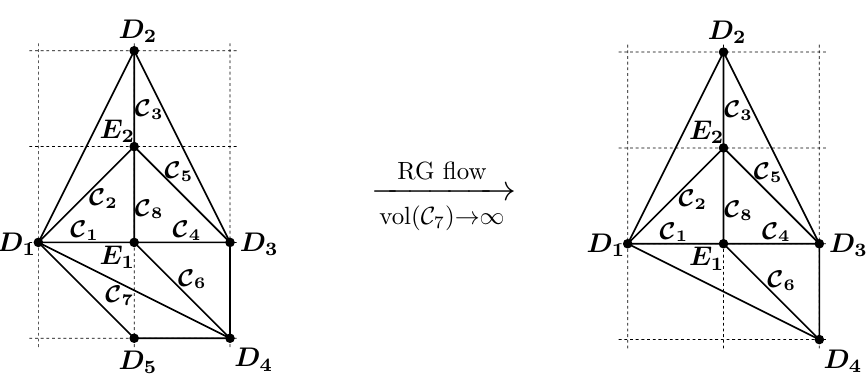
Figure 16 . Decoupling a divisor from E 22 ; 3 2 resolution (e) yields an SL(2 ; Z )-transformed version of a crepant resolution of the E 12 ; NL singularity.